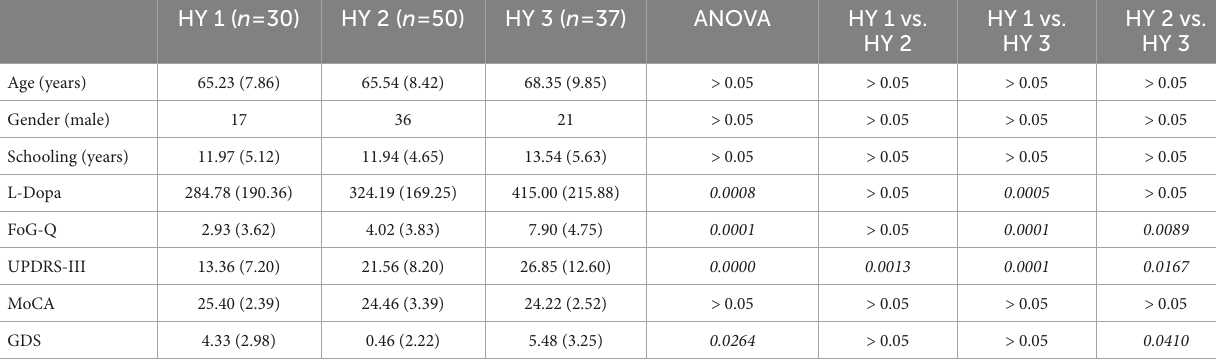
TABLE 1 Clinical and demographic characteristics of participants.